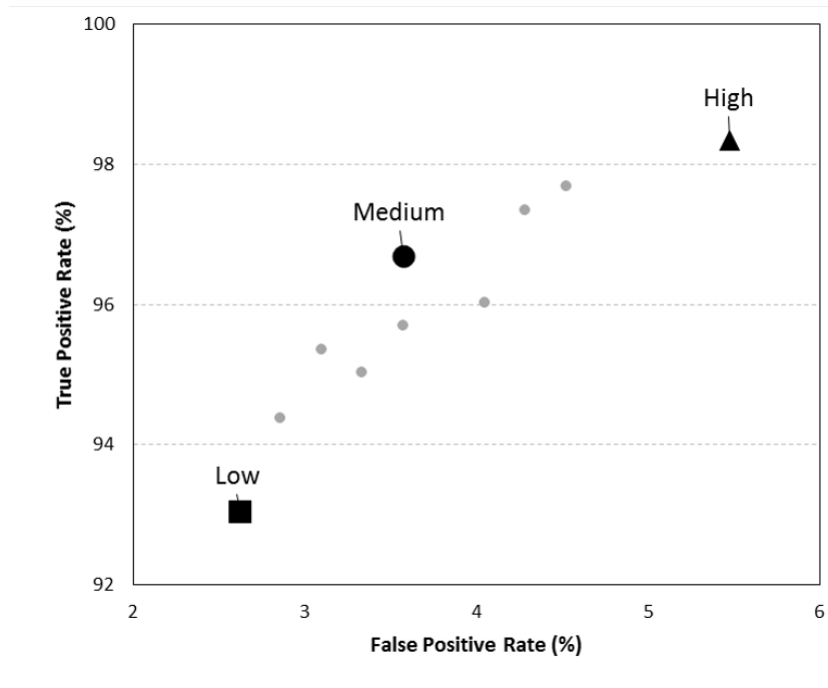
Figure 2. ROC curve with the 10 sets of thresholds that presented the best J-index when the algorithm was tested with the test set sampled at 50 Hz—Black square: Low sensitivity level; Black doth: Medium sensitivity level; Black triangle: High sensitivity level sensitivity.